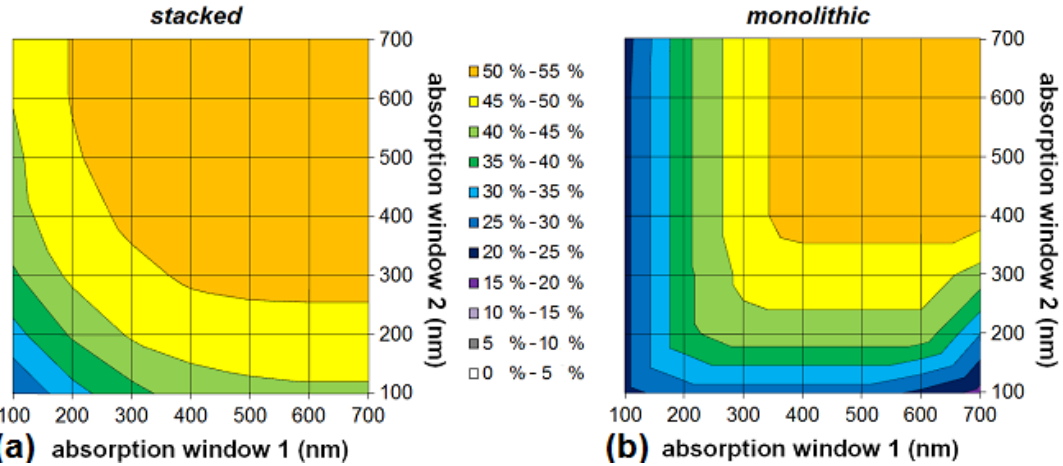
Figure 10. The maximum efficiency in the ideal scenario for an organic stacked ( a ) and monolithic ( b ) tandem cell as a function of the absorption windows of the subcells. “Absorption window 1” refers to the first subcell with the highest absorber bandgap, i.e. , the top cell directed at the